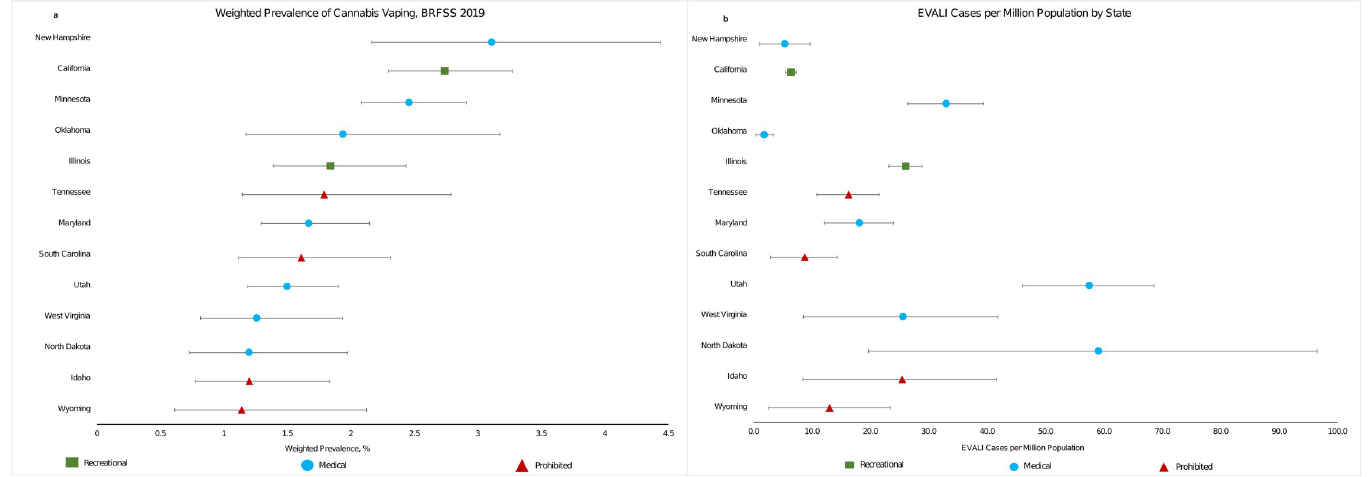
Fig 1. a: Cannabis vaping prevalence among persons aged 18–64 years by state, the behavioral risk factor surveillance system, 2019. b: EVALI cases per million population by state.